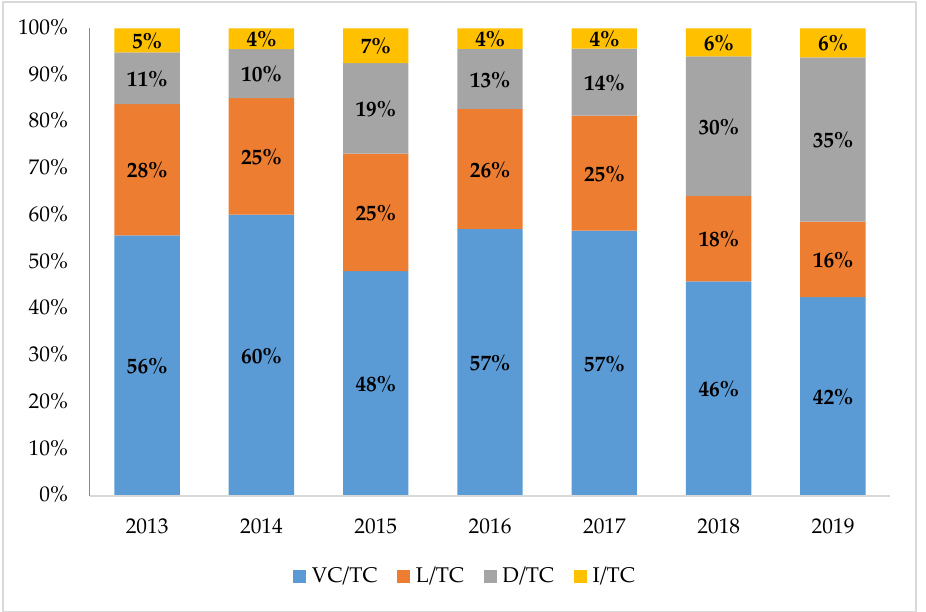
Figure 2. Incidence of the single cost categories as parts of the total costs. First, in terms of variable costs (VC), they are the cost category that affects revenues most of all. Specifically, Figure 3 further breaks down the individual variable cost